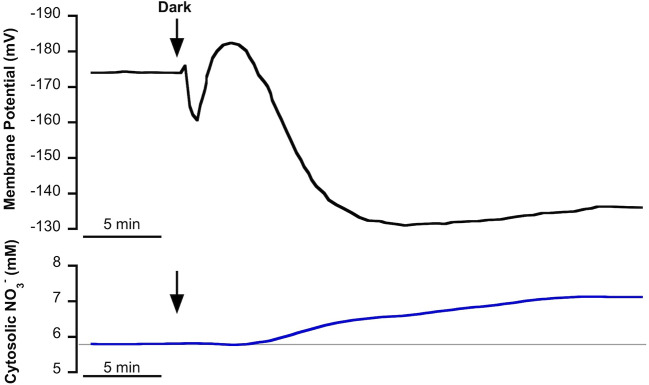
Effect of light-dark transition on plasma membrane potential (Em, mV) and cytosolic NO3− (mM) in Posidonia oceanica mesophyll leaf cells, incubated in natural seawater. Traces are representative examples of intracellular nitrate-selective microelectrode recordings from 10 independent experiments. Arrows indicate the onset of dark treatment. Auxiliary grey line shows the standard cytosolic NO3− concentration under light conditions (150 µmol photons m−2 s−1). Mean values and statistics are indicated in the text.